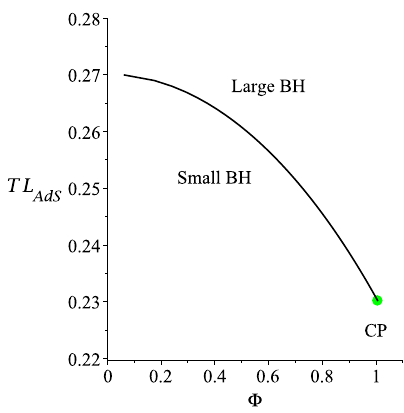
Figure 16 . Phase diagram in T { (cid:8) plane for d = 4 spherical black holes . We illustrate the phase diagram in the T (cid:0) (cid:8) plane for (cid:12)xed pressure P‘ 2 = 3 = (8 (cid:25) ). The green dot shows the critical point, while the black line marks the coexistence curve for the (cid:12)rst order phase transition. In this (cid:12)gure, the coupling was set to (cid:21)=‘ 6 = 0 :